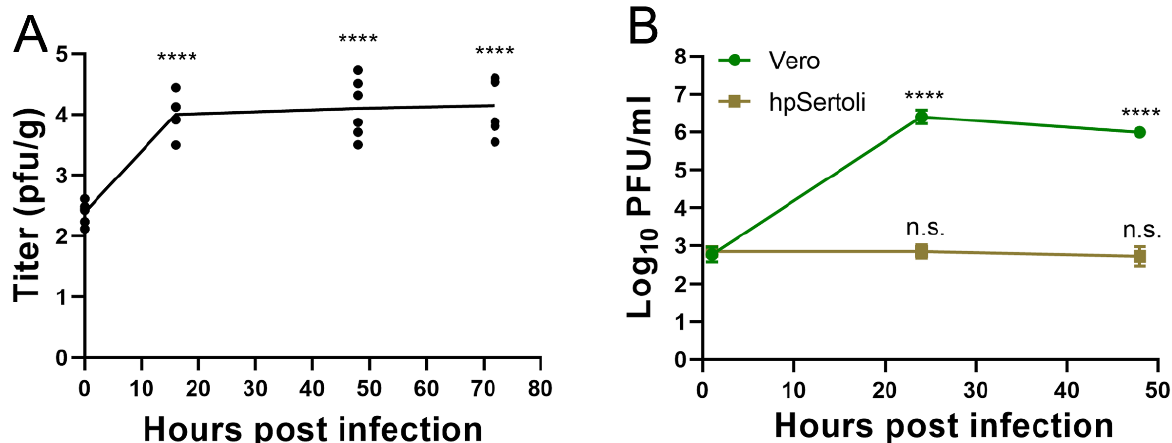
Figure 3. SARS-CoV-2 replicates in testicular cells but not hpSertoli cells. ( A ) Ex vivo infection of testes with SARS-CoV-2. Symbols show each well with a piece of testes, the line shows the average. **** denotes a p < 0.0001 in a one-way ANOVA test of each timepoint compared to the initial timepoint. Representative of two independent experiments. ( B ) Growth curve in Vero cells or hpSertoli cells at an MOI of 10. Limit of detection is 4 PFU/mL. **** denotes p in a one-way ANOVA test of each timepoint compared to the initial timepoint. Representative of two independent studies. Error bars of ( A ) and ( B ) represent standard deviation. n.s. stands for not significative, p ≥ 0.05.